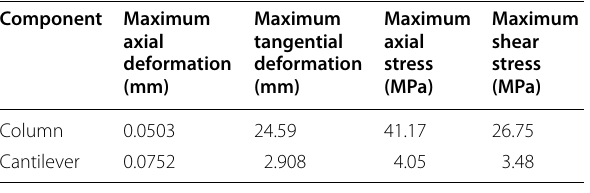
results when the cantilever